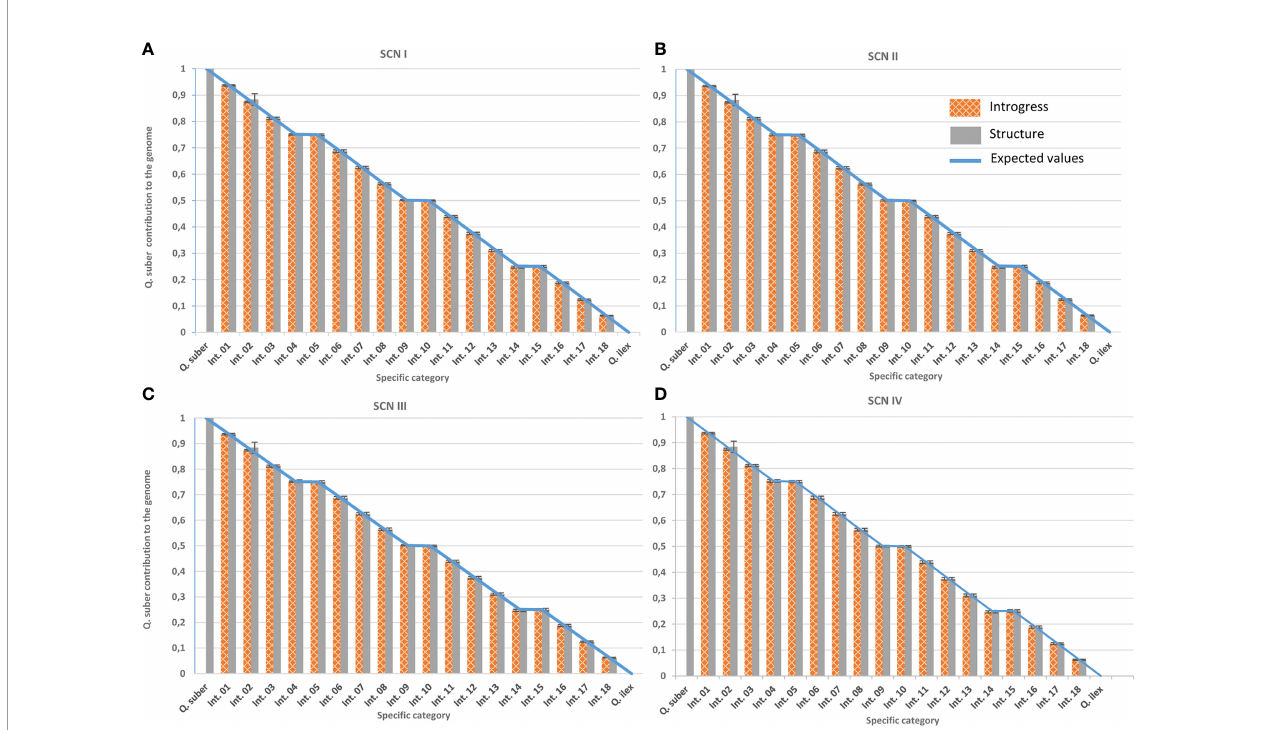
FIGURE 6 | Performance of classi fi cation tools under the different imputation scenarios. Genomic contribution of Q. suber is estimated using Structure ’ s qs (plain grey) and Introgress hybrid index (gridded orange) on virtual individuals generated with SimHyb (pure species and 18 intermediate categories). Expected values are represented by a blue line. Standard deviations are also indicated. (A) Imputation scenario I; (B) imputation scenario II; (C) imputation scenario III; (D) imputation scenario